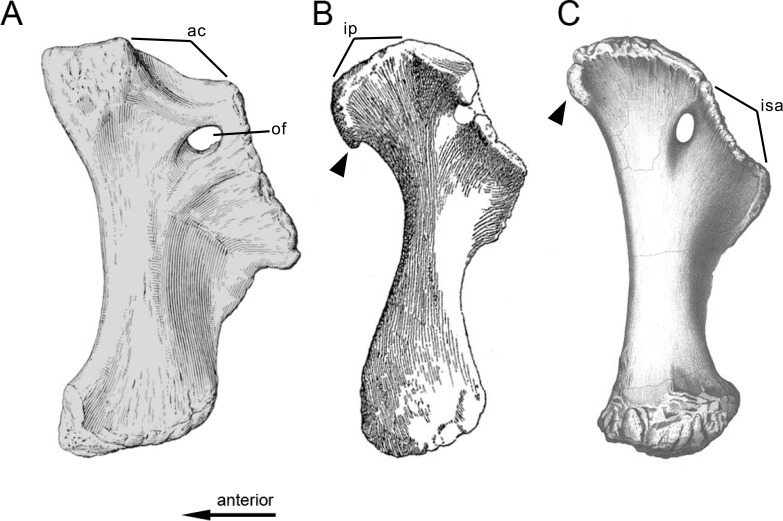
Neosauropod pubes.Left (A, C) and right (B, reversed) pubis of Camarasaurus supremus AMNH 5761 (A; modified from Osborn & Mook, 1921), Dicraeosaurus hansemanni MB.R.4886 (B; modified from Janensch, 1961), and Brontosaurus excelsus YPM 1980 (C; modified from Ostrom & McIntosh, 1966) in lateral view. Note the different sizes of the ambiens process (C414, arrowheads: absent, A; hook-like, B; incipient, C). Abb.: ac, acetabular surface; ip, iliac peduncle; isa, ischial articular surface; of, obturator foramen. Scaled to same length.